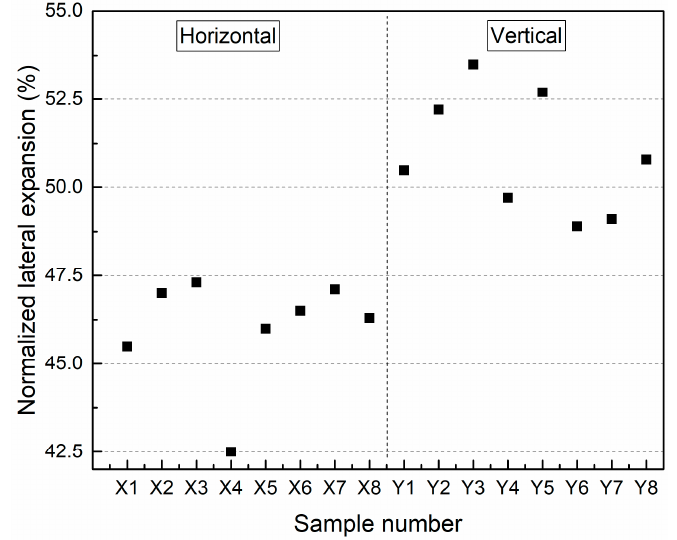
Figure 10. Normalized lateral expansion in percentage for the horizontal and vertical specimens.